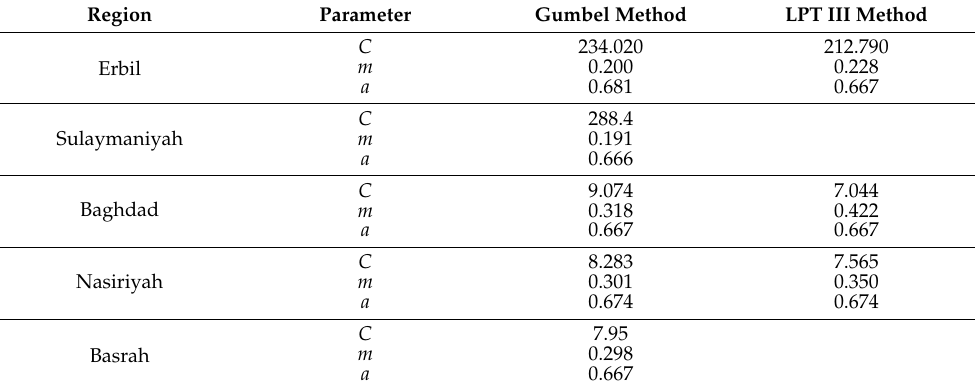
Table 4. The values of the parameters that are used in the development of formulas in different cities of Iraq